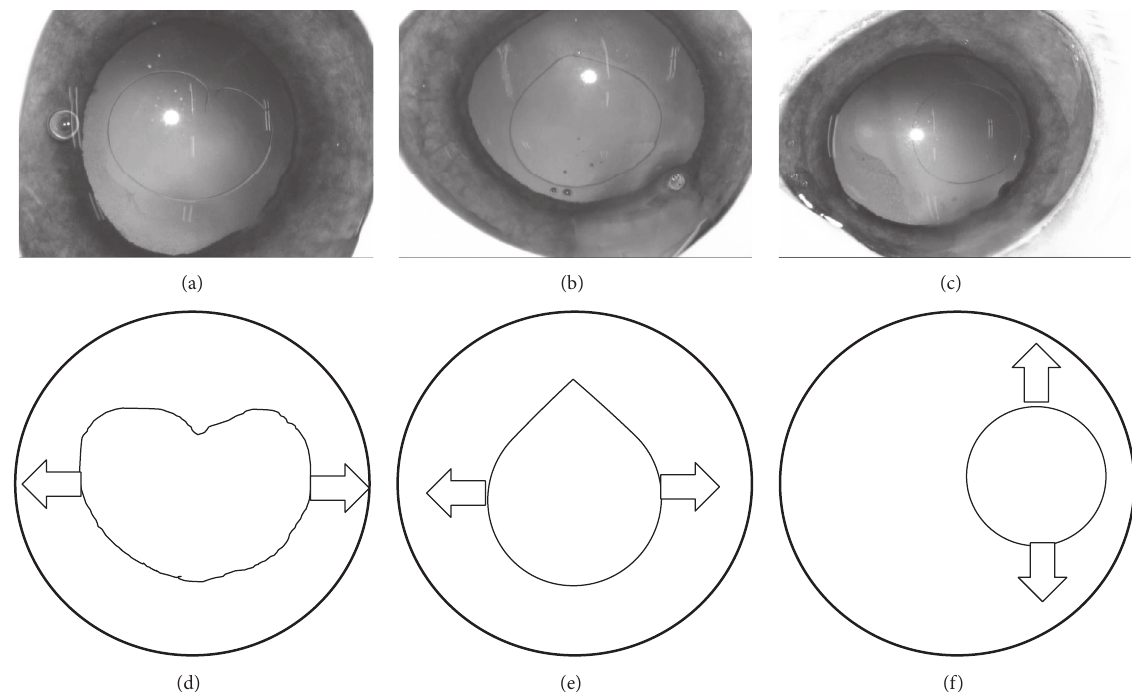
Figure 1: Representative shapes of irregular-shaped continuous curvilinear capsulorhexis (CCC). Three types of irregular CCC—heart- shaped (a), teardrop-shaped (b) and eccentric (c)—are shown. (d), (e), and (f) show the location of 2 jigs pulling capsule edges